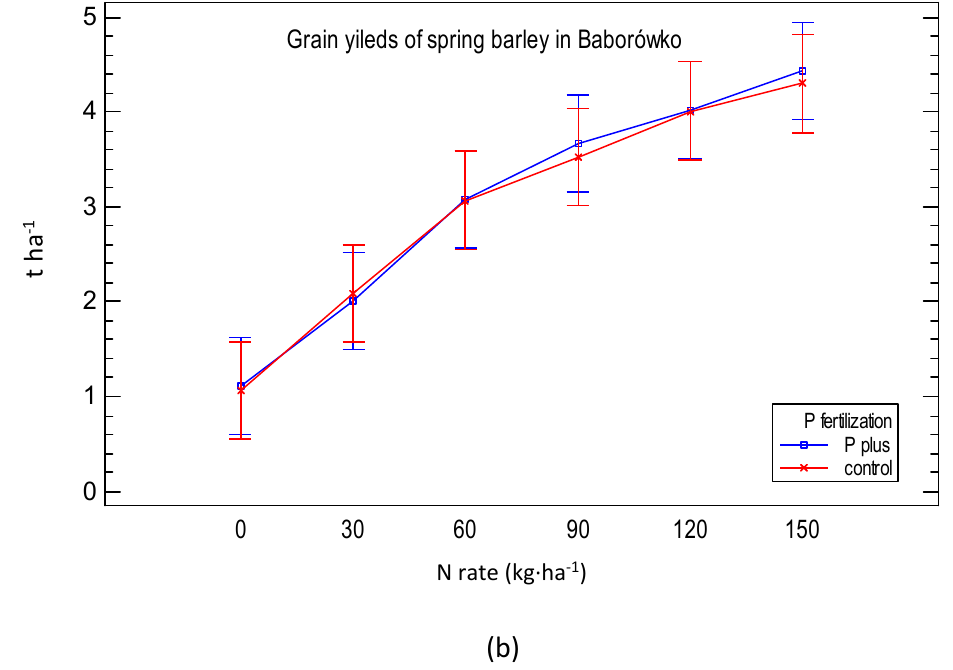
Figure 8. Grain yields of spring barley at increasing additions of N fertilizer at the P-plus and control levels of P, 95% Tukey HSD intervals; n = 384 for each location (P fertilization ( a ) Grab ó w HSD 0.349, ( b ) Babor ó wko HSD